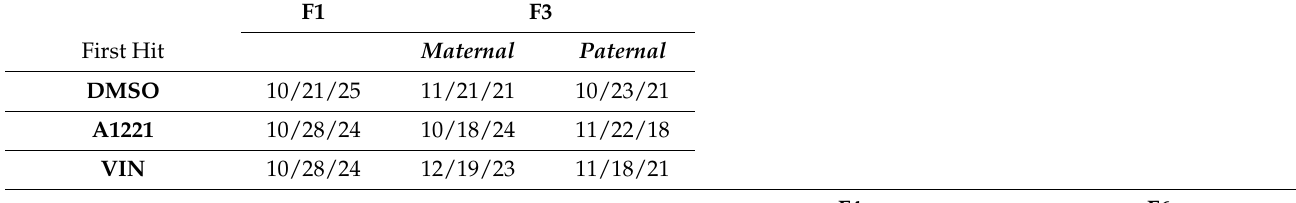
Table 1. Sample sizes, indicated as # litters/# individual females/# individual males. F1